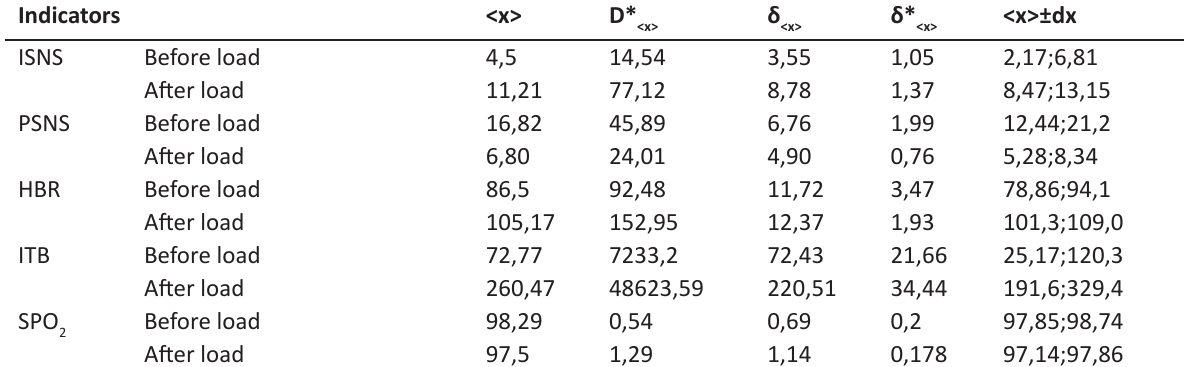
Table 4. Cardio-respiratory indicators of 2 nd group boys’ functional system after physical load